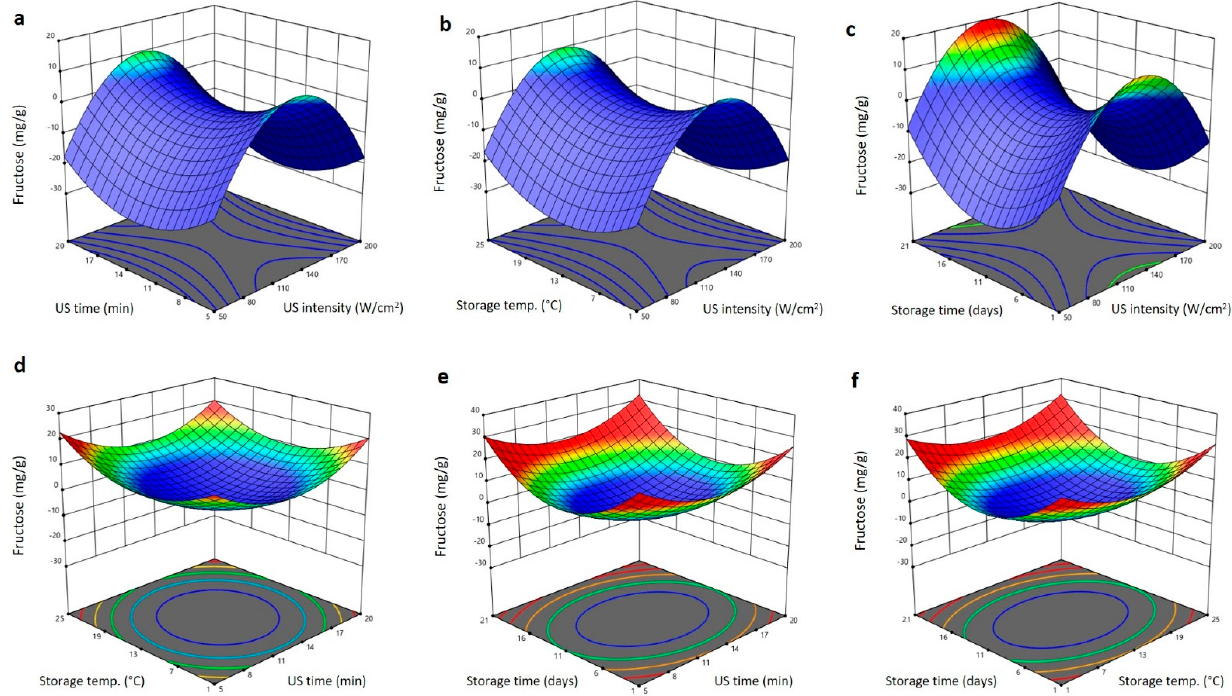
Figure 9. Response surface plots of fructose content of Barhi dates as a function of US time and US intensity ( a ), storage temperature and US intensity ( b ), storage time and US intensity ( c ), storage tem- perature and US time ( d ), storage time and US time ( e ), and storage time and storage temperature ( f